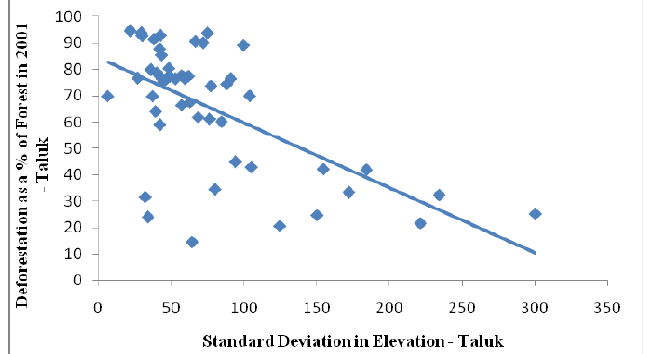
Figure 13b. Relationship between variation in elevation and the distribution of deforestation as a percentage of the forest area existing in 2001, for